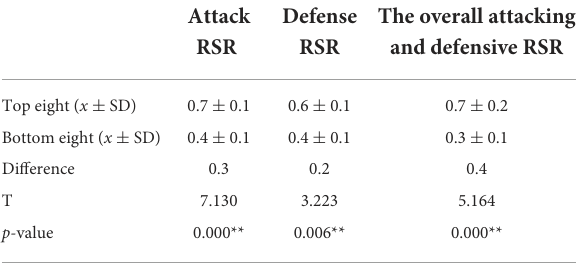
TABLE 6 The differences in the RSR values of attack-defense performance between the top eight and bottom eight teams.